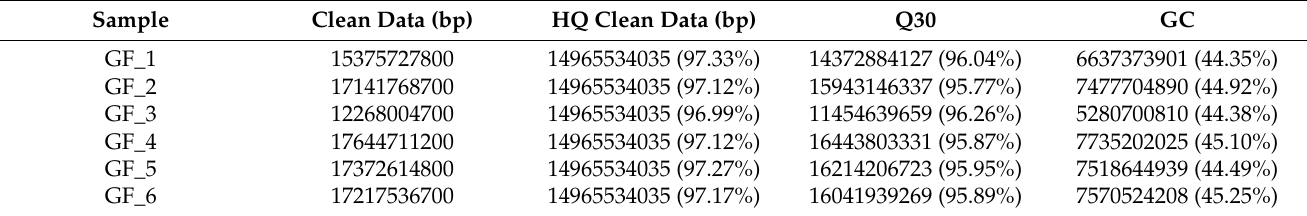
Table 1. Summary statistics of lncRNA and mRNA sequencing data.